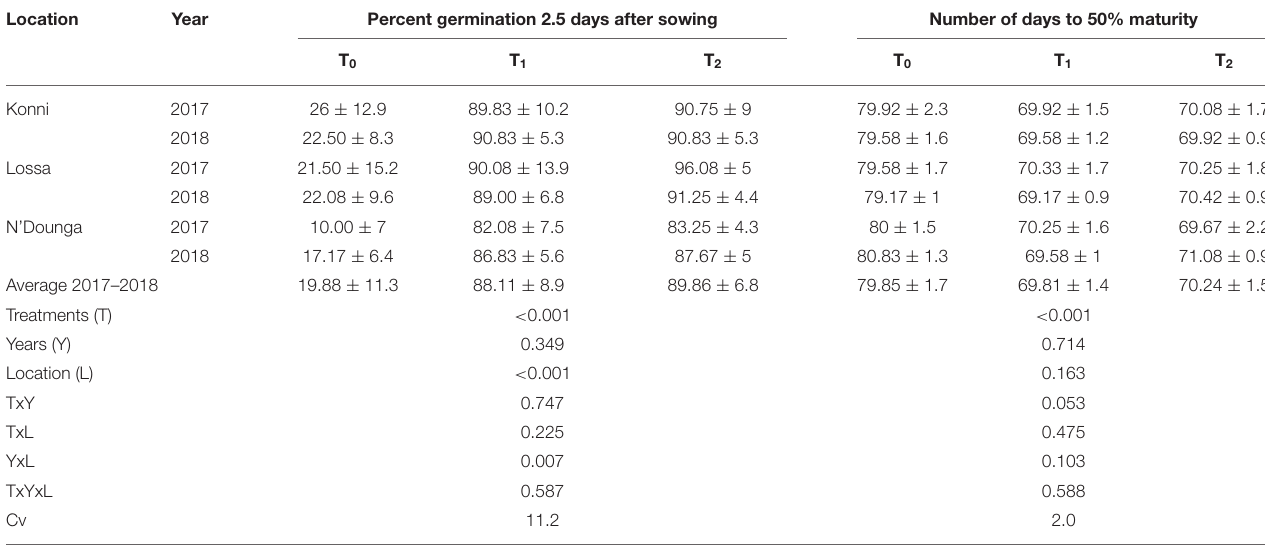
TABLE 4 | Effects of treatment on percent germination 2.5 days after sowing and number of days to 50% maturity including standard errors in parenthesis.